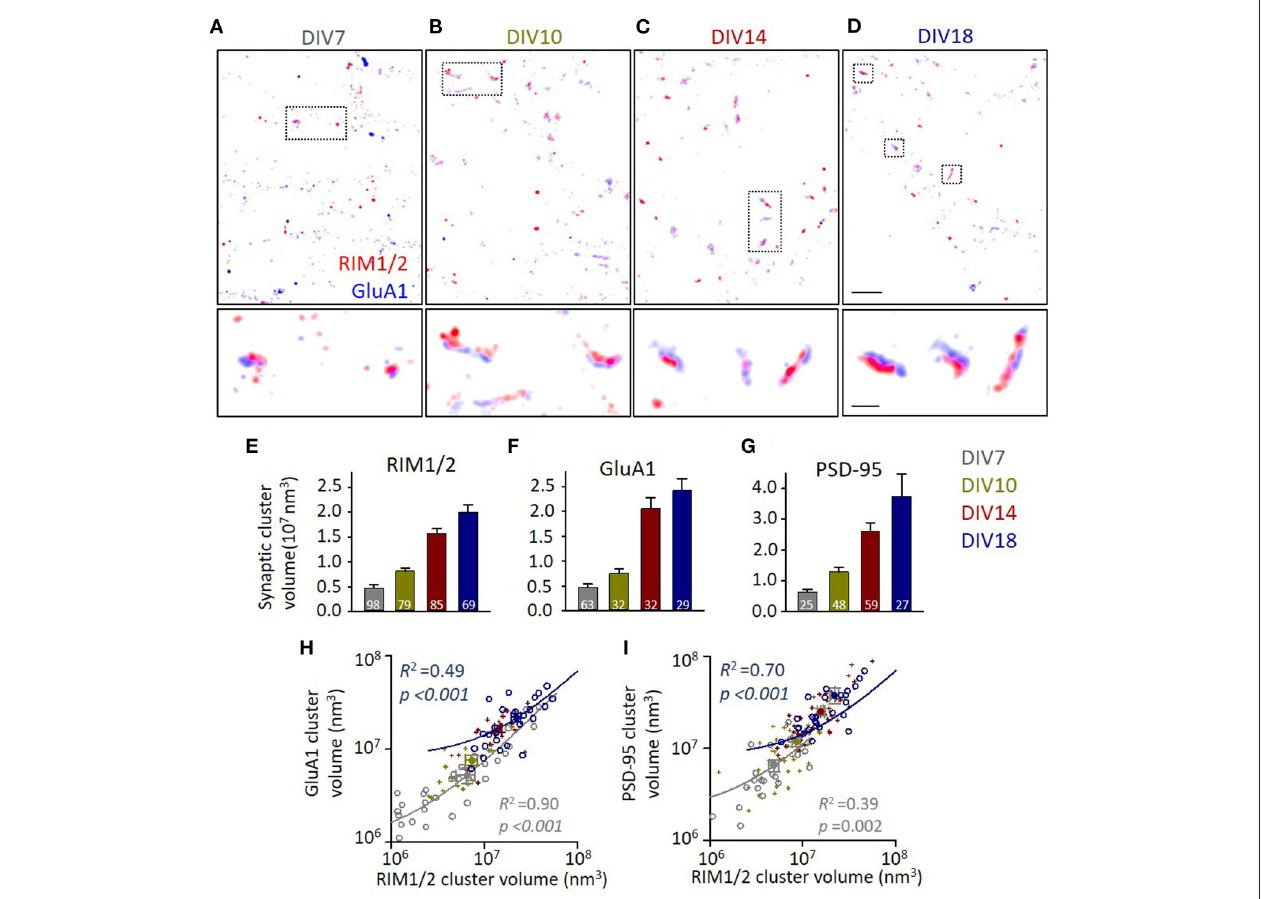
FIGURE 1 | Synapse volumes increase correlatively during synaptic maturation. (A–D) Representative distribution of RIM1/2 and GluA1 under stochastic optical reconstruction microscopy (STORM). Scale 2 µ m in top panels and 500nm in lower panels. (E–G) Volumes of identified synaptic RIM1/2, GluA1, and PSD-95 clusters across different developmental stages. Numbers in bars denote the synapse numbers. (H,I) Correlations between the volumes of GluA1 and RIM1/2 clusters (H) and the volumes of PSD-95 and RIM1/2 (I) within the same synapses. Linear regressions were conducted on synapses of DIV7 (gray circles and line) and DIV18 (dark blue circles and line). Data from synapses of DIV10 and 14 were plotted with dark yellow and dark red crosses. Also refer to Supplementary Figures 1 , 2 and Supplementary Table 1 for more details on correlations and statistics. All experiments were repeated ≥ 3